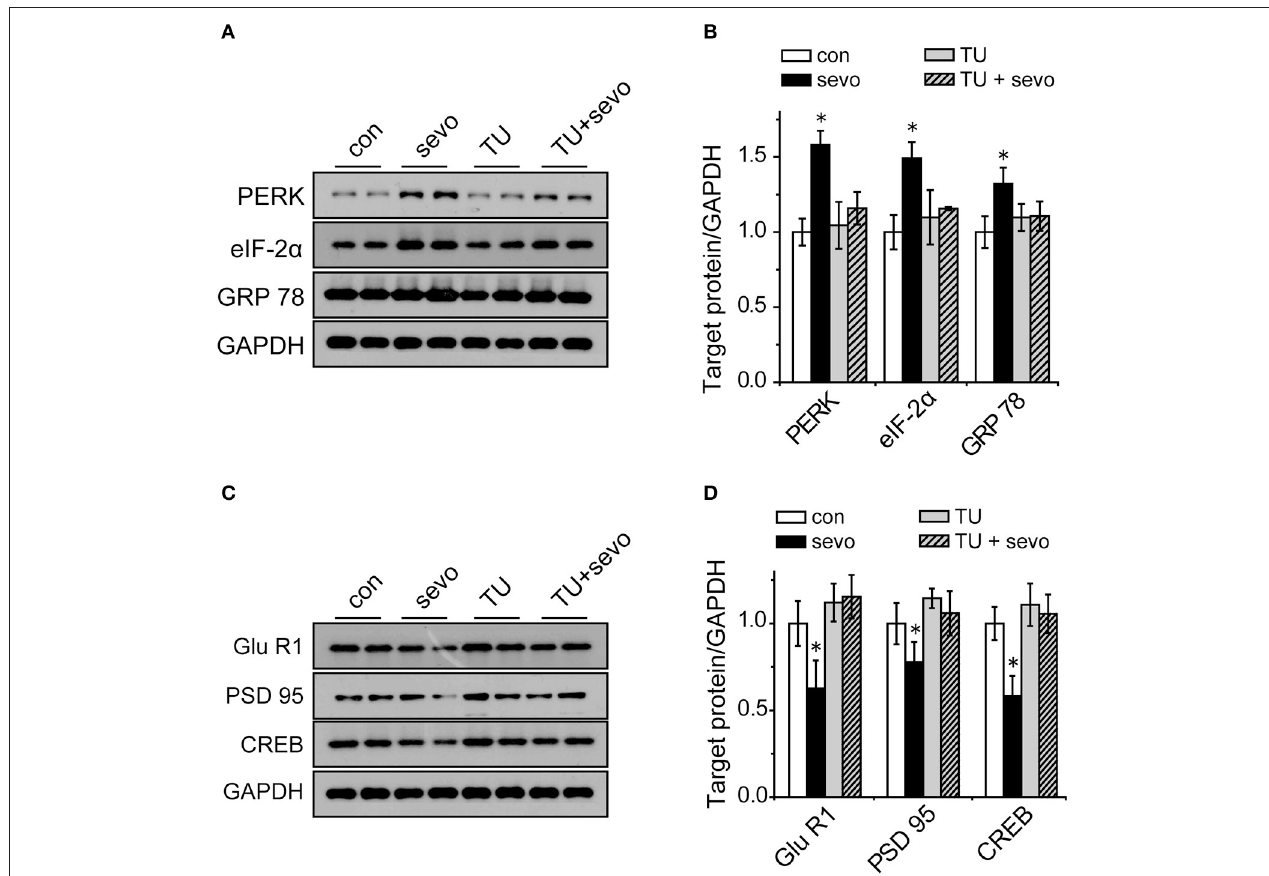
FIGURE 6 | Increased expression of GRP 78, PERK, and eIF-2 α and decreased expression of GluR1, PSD95, and CREB were reversed by the ER stress inhibitor TUDCA. (A) Representative samples showing the expression levels of GRP 78, PERK and eIF-2 α in the hippocampi of the control group, the sevoflurane group, the TUDCA group and the TUDCA + sevoflurane group; (B) Densitometric analysis of GRP 78, PERK, and eIF-2 α . N = 3–6 times for each protein. One-way ANOVA; * p < 0.05 vs. control. Data are presented as the means ± SEM. (C) Representative samples showing the expression levels of GluR1, PSD95, and CREB in the hippocampi of the control group, the sevoflurane group, the TUDCA group and the TUDCA + sevoflurane group; (D) Densitometric analysis of GluR1, PSD95, and CREB. One-way ANOVA; * p < 0.05 vs. control. Data are presented as the means ±